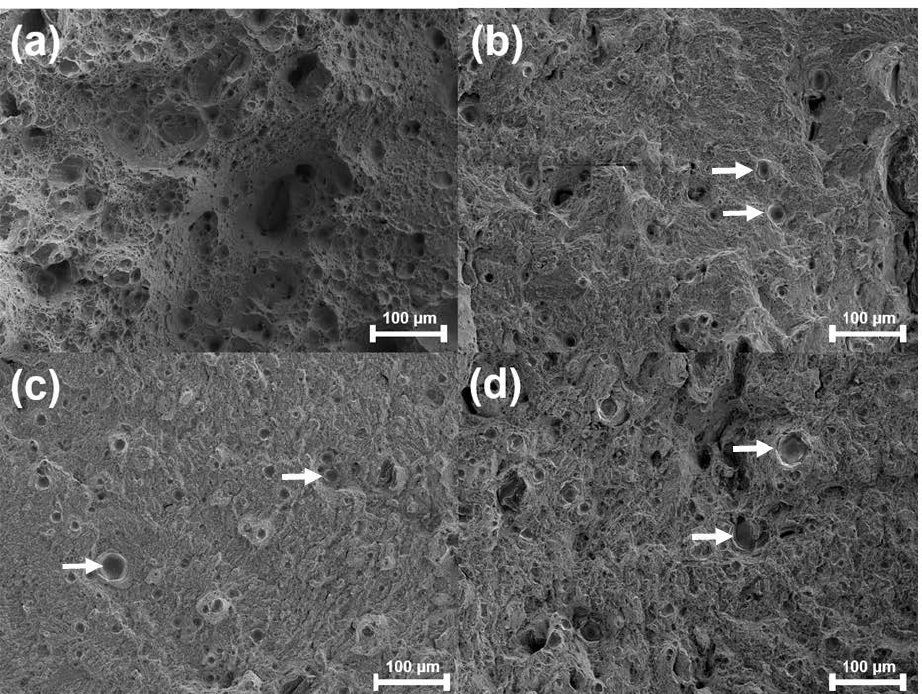
Figure 12. SEM fractographic images of BD tensile samples ( × 200): ( a ) as-built condition; ( b ) after 6 h aging at 450 °C without ST; ( c ) after 750 °C ST for 2 h and aging at 450 °C for 6 h; and ( d ) after 850 °C ST for 2 h and aging at 500 °C for 6 h.